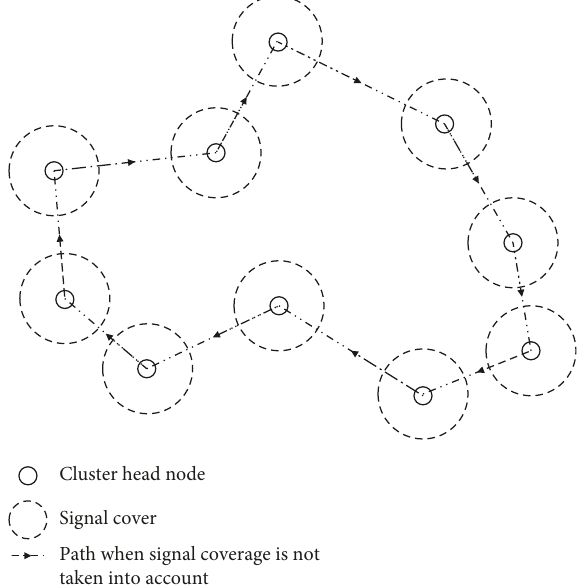
Figure 4: An example of considering node wireless signal coverage.